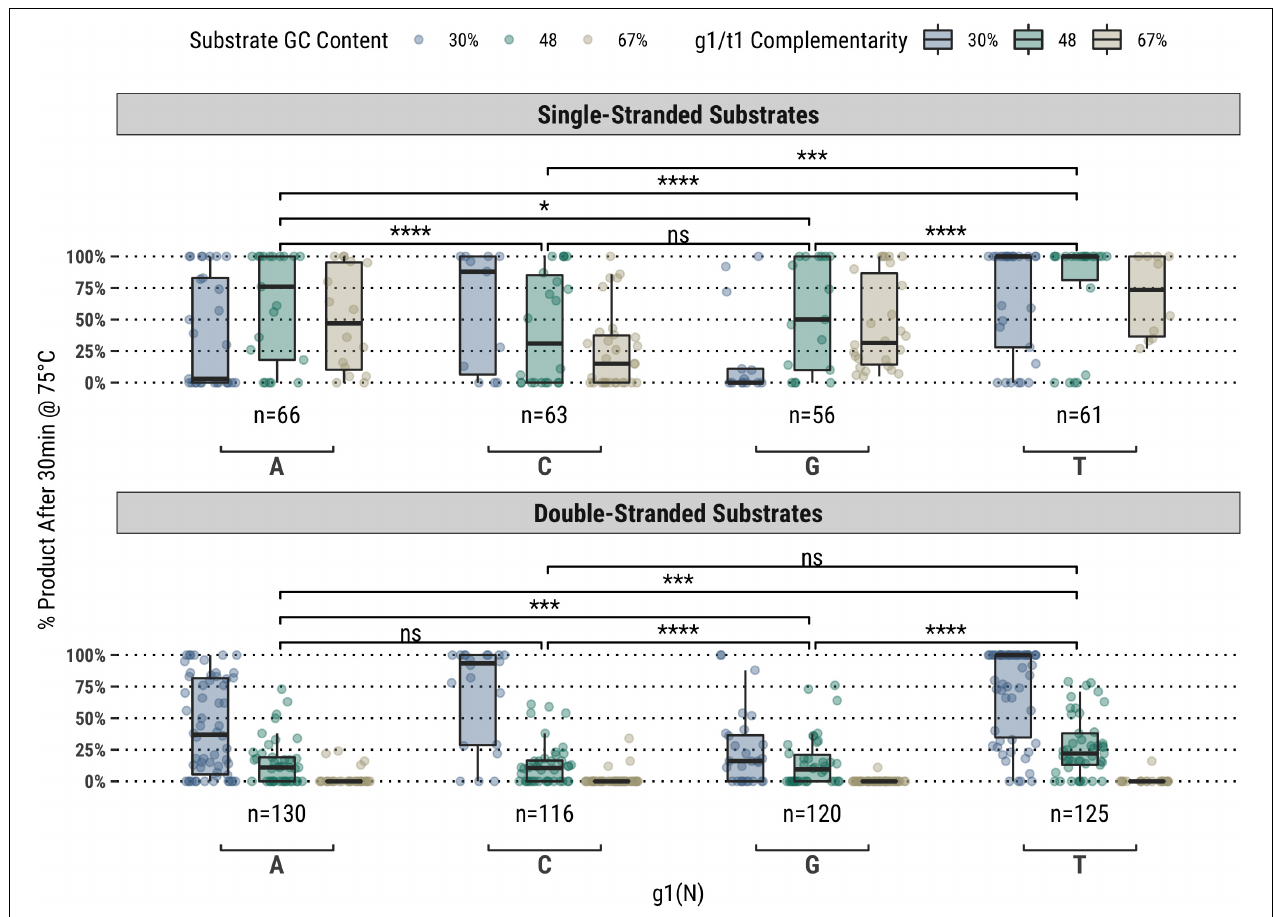
FIGURE 1 | In a population of fully-complementary 17 nucleotide-long guides targeting randomized-sequence single- and double-stranded substrates of various GC contents, the first position of the guide (g1) was strongly correlated with overall guided-endonuclease activity of TtAgo. In particular, guides with g1T performed better than those with g1V. Each g1 grouping is divided to show the overall GC content of the substrate targeted, however, the significance levels shown are for each g1 grouping against the others. Boxplots have been annotated for statistical significance between relevant groups using the following labels: ns (not significant) for p > 0.05; ∗ for p ≤ 0.05; ∗∗∗ for p ≤ 0.001; and ∗∗∗∗ for p ≤